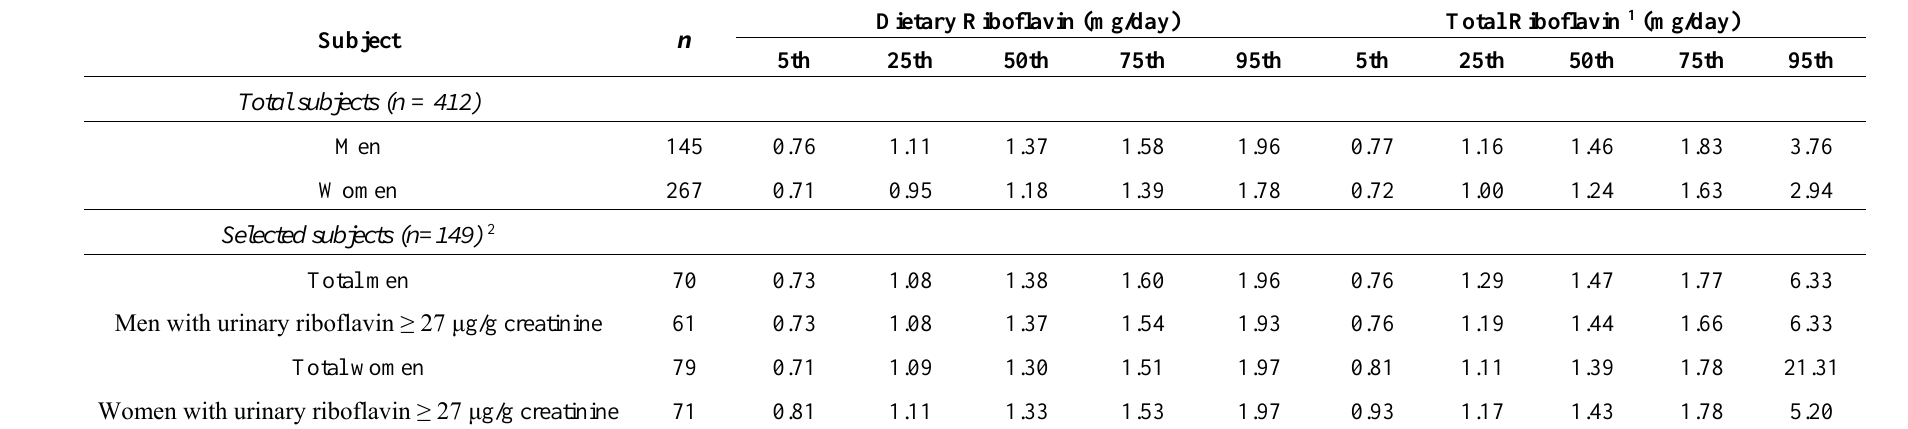
Table 4. Percentile values of dietary and total riboflavin intakes of Korean adults.